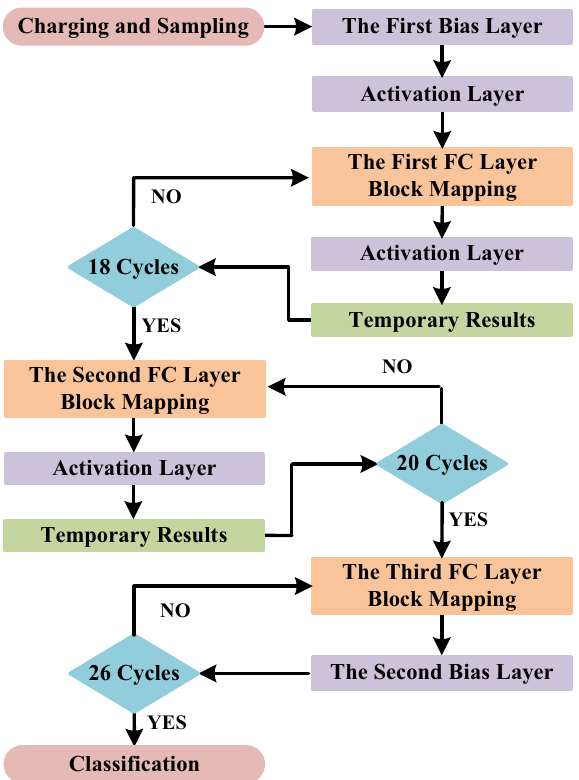
Figure 7. Flowchart of the binary memristor-based Braille recognition